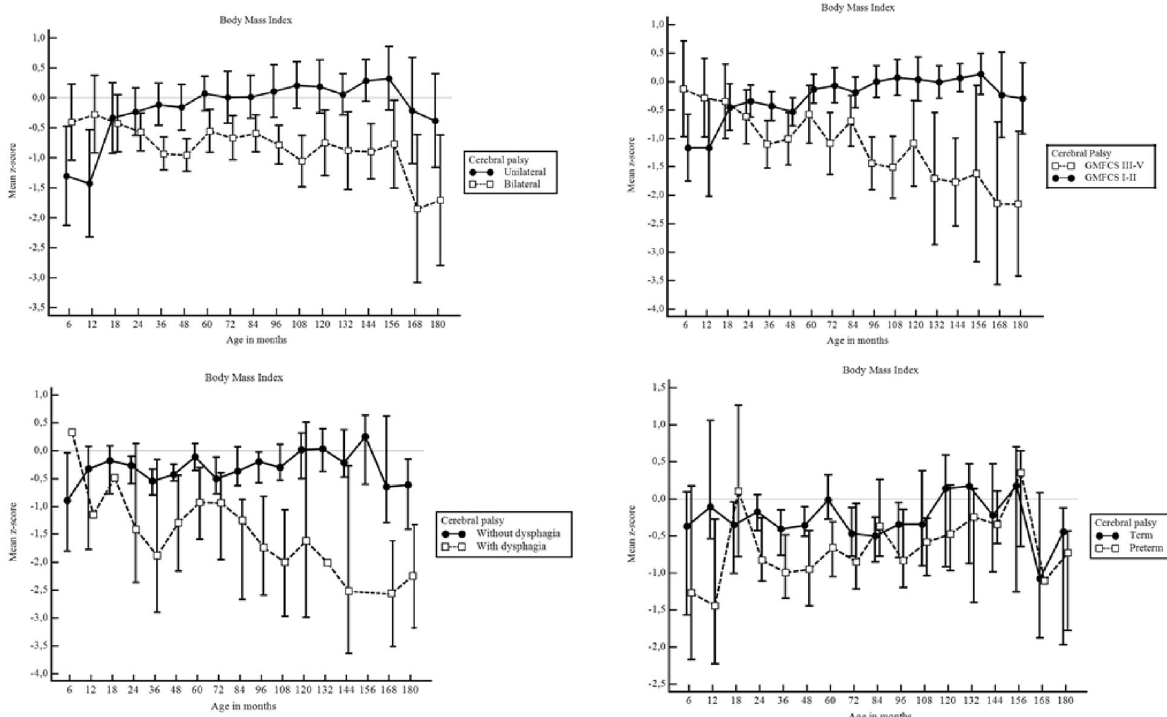
Figure 3. Body Mass Index for age mean z-scores with 95% CI for weight by age in months among children unilateral vs. bilateral cerebral palsy, Gross Motor Function Classification System level I–II vs. level III–V, with and without dysphagia, and with and without prematurity (n = 1536). If the 95% CI bars overlap, the difference between the two z-score means is not statistically significant (p >